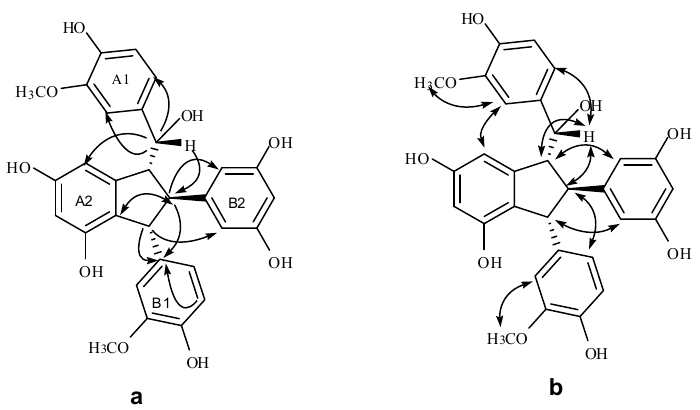
Figure 4. The significant HMBC ( a ) and NOESY ( b ) interactions of 4 .